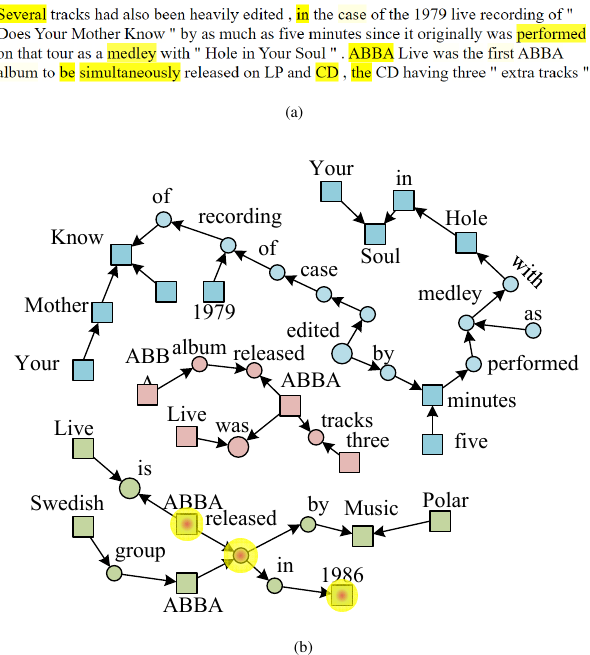
Fig. 10 (a) Visualization of the attention weight on partial text and (b) attention weight on the SG nodes. The yellow circles are the weights. Subject: “Does Your Mother Know”, object: “ABBA”, and relation: